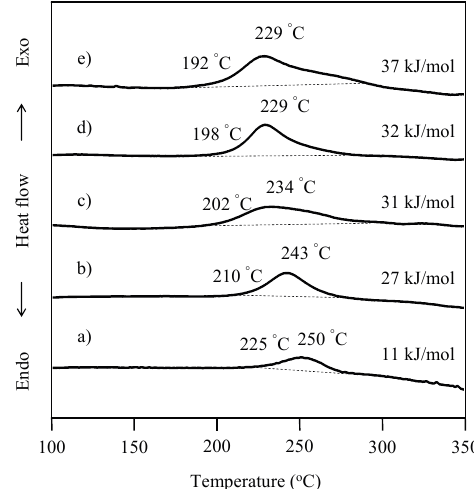
Figure 8. DSC curves of P(P-4va/BuA) with 63 (a), 58 (b), 50 (c), 33 (d), and 14 (e) mol % of BuA composition. The exothermic amounts were calculated on the basis of the benzoxazine monomeric